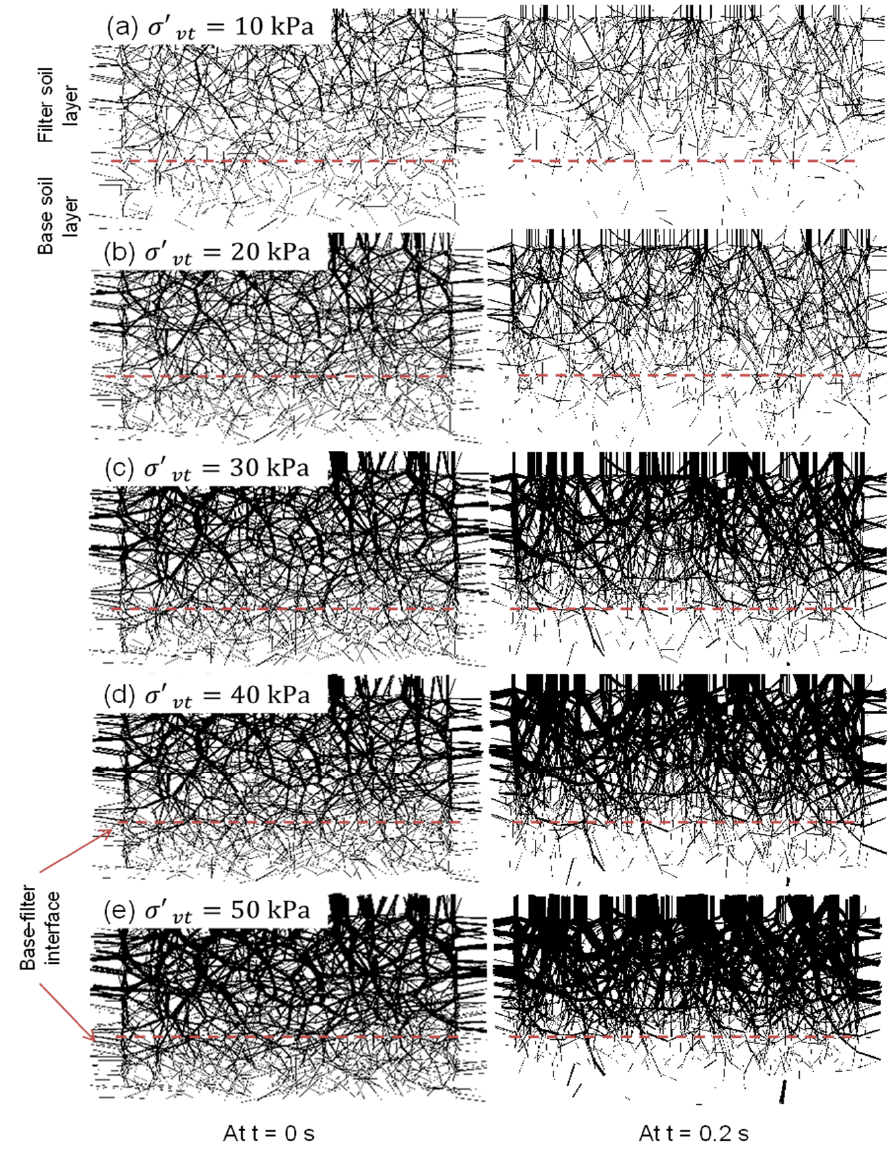
Figure 4. Initial contact force distribution at σ (cid:48) vt = ( a ) 10 kPa, ( b ) 20 kPa, ( c ) 30 kPa, ( d ) 40 kPa, and ( e ) 50 kPa for specimen NF1-NB (Note: time t = 0 s and t = 0.2 s represent conditions before and after the coupled simulations, respectively).